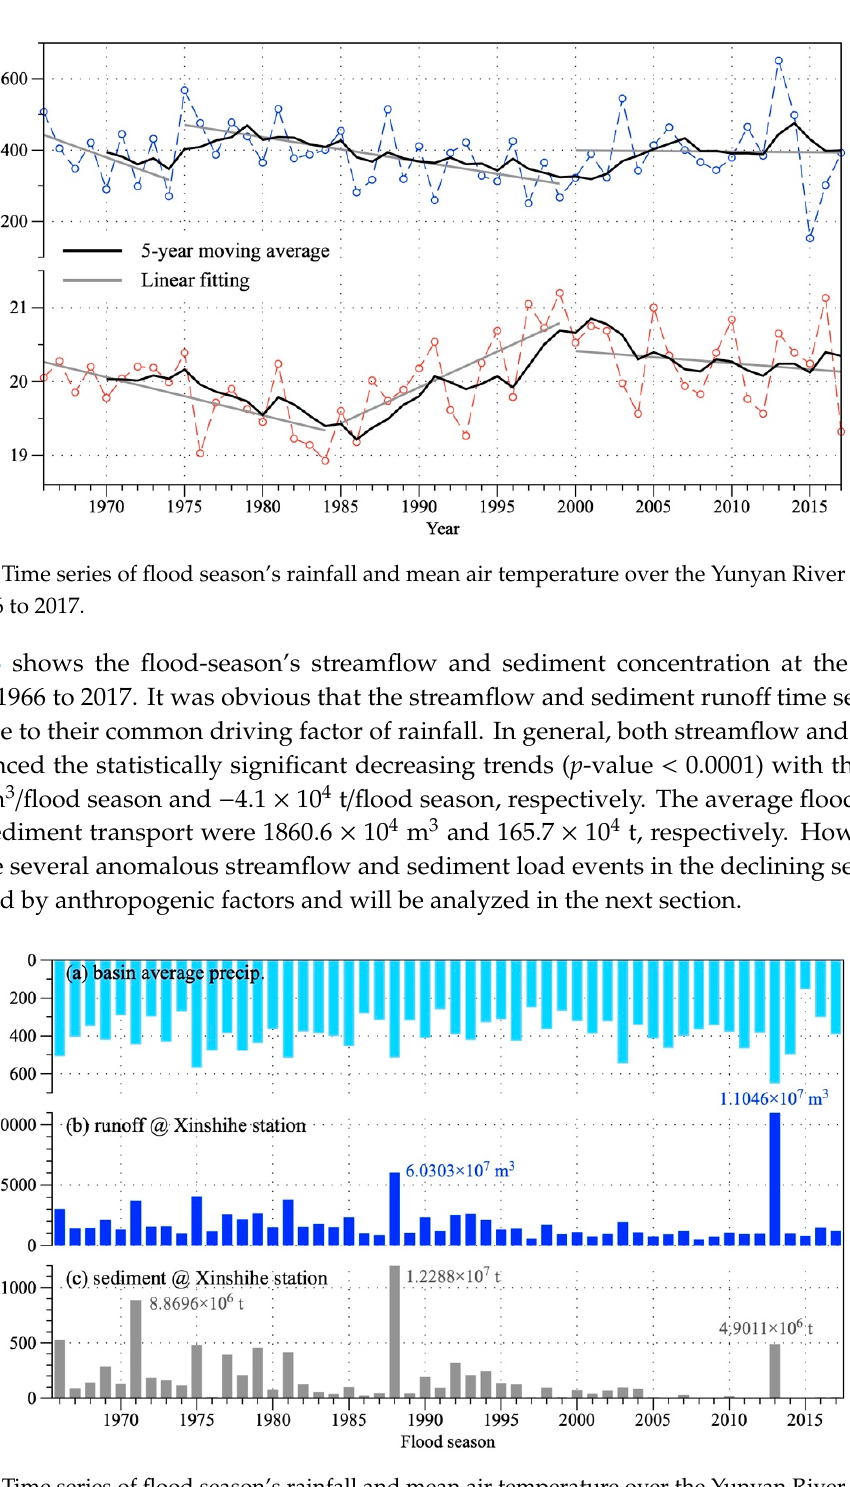
Figure 3. Time series of flood season’s rainfall and mean air temperature over the Yunyan River Basin from 1966 to